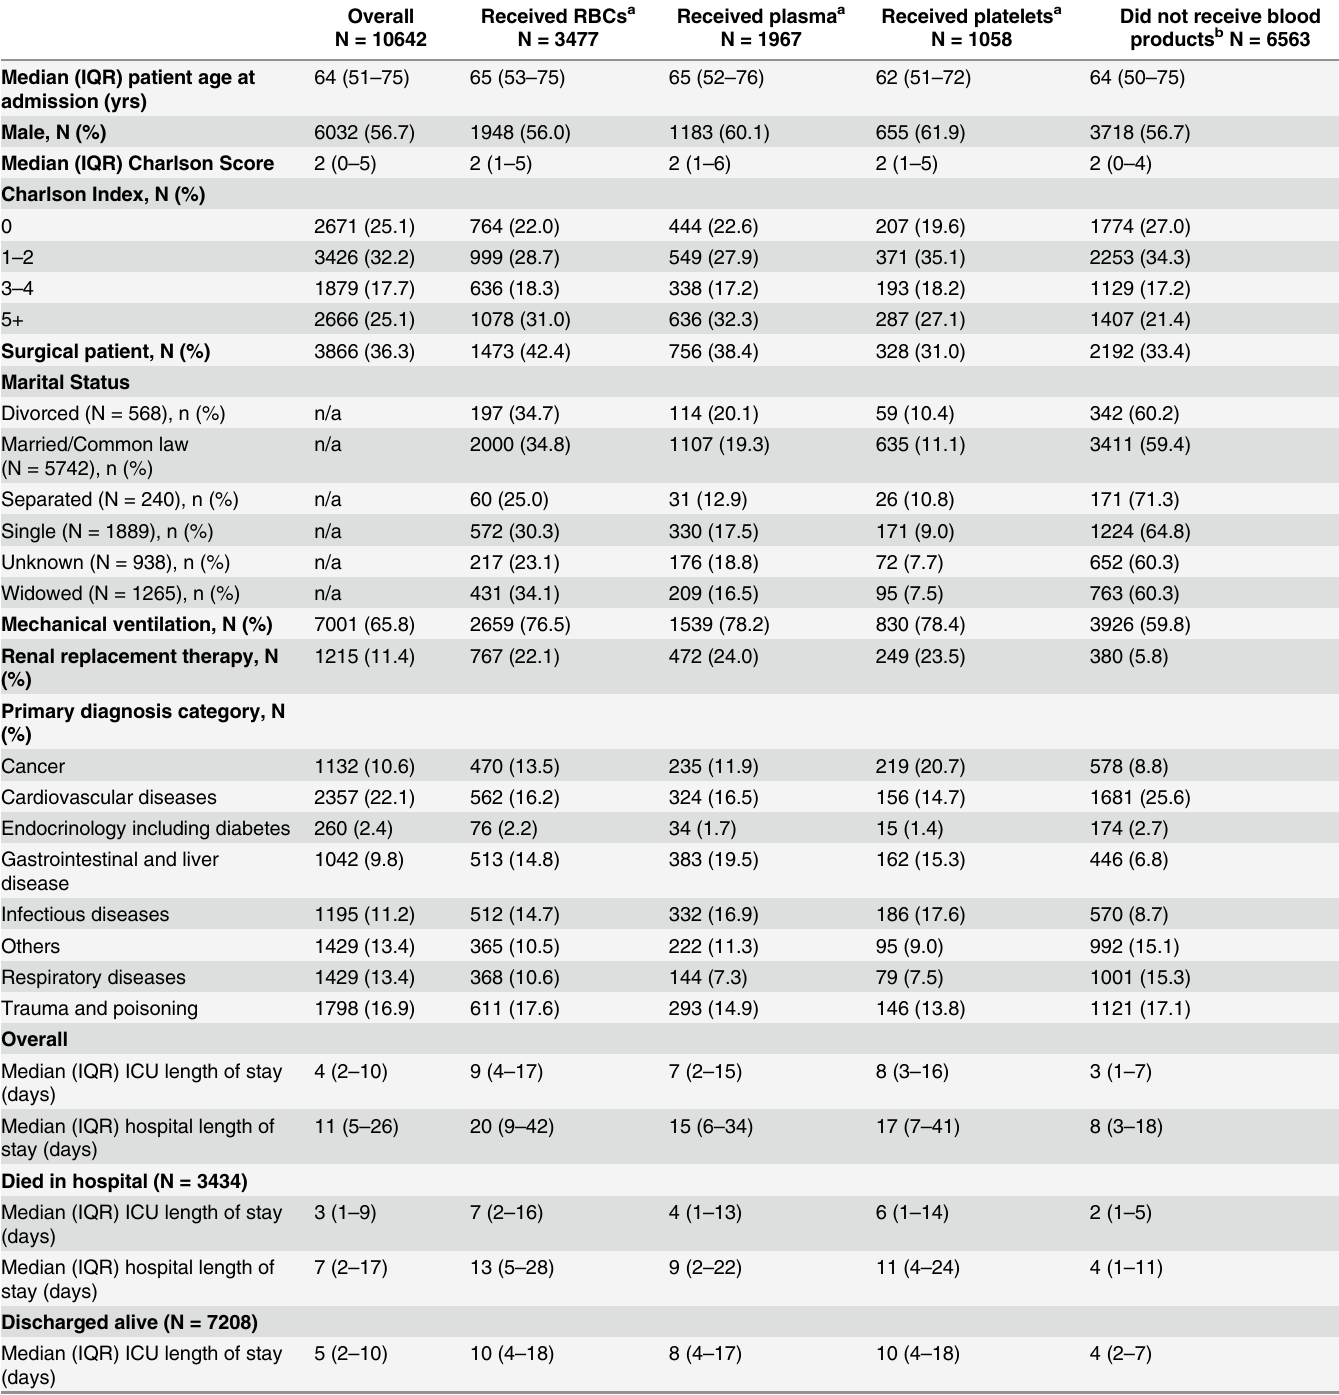
Table 1. Characteristics of patients admitted to the